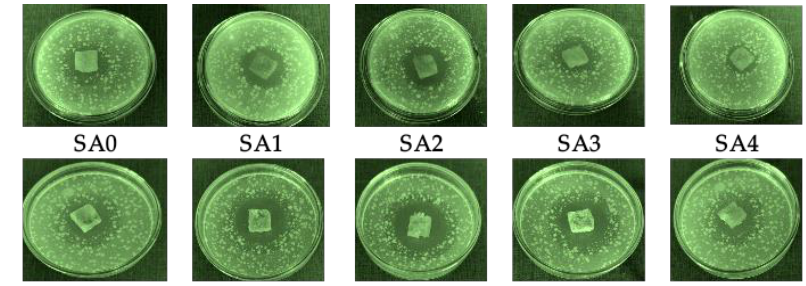
Figure 8. Antimicrobial activity against Staphylococcus aureus and Escherichia Coli of the obtained hydrogels.